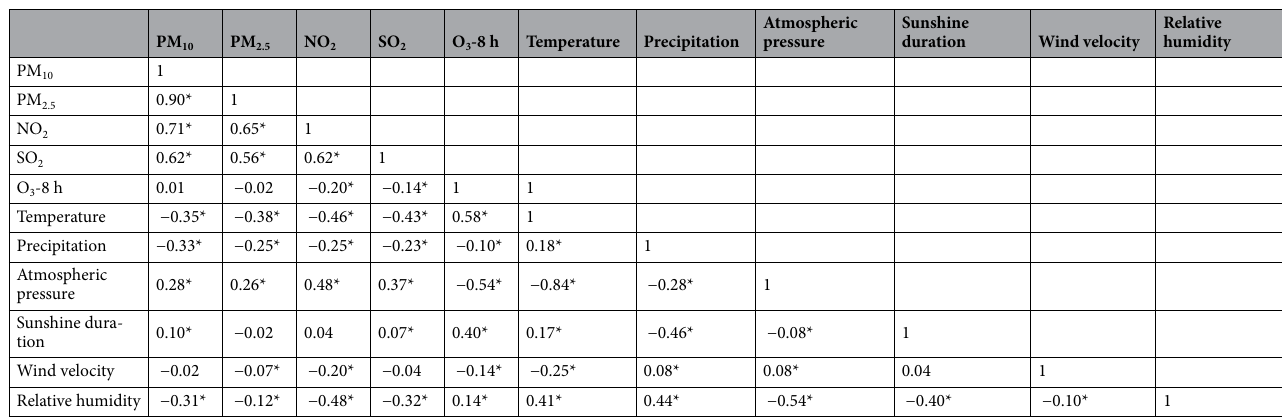
Table 1. Spearman’s correlation coefficient matrix between daily air pollutant concentrations and meteorological factors in Qingdao, 2014–2019. PM 10 particles with aerodynamic diameter less than 10